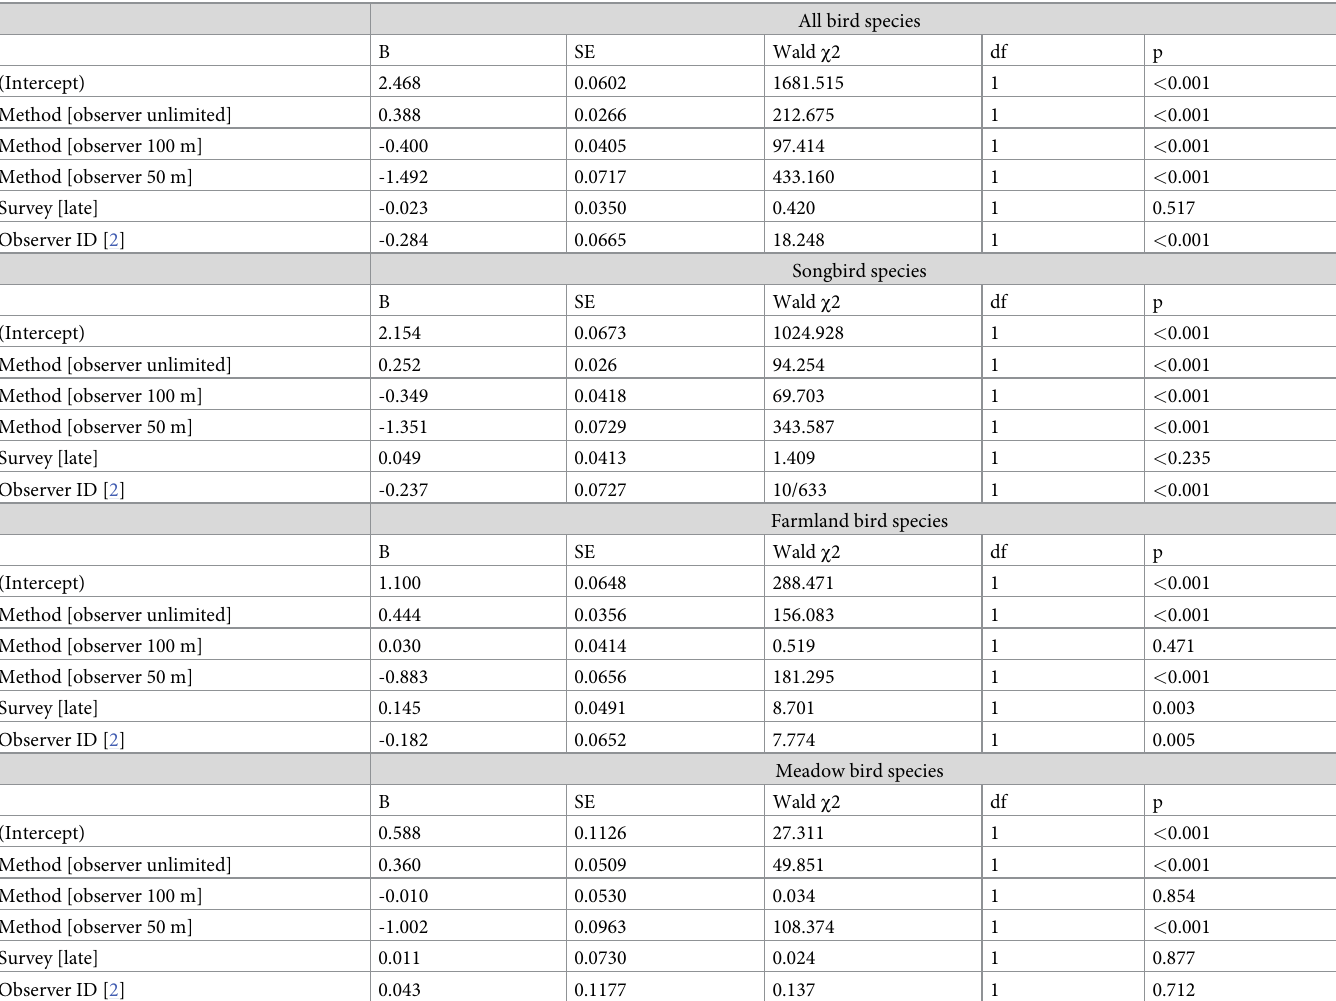
Table 1. Results of three generalised estimating